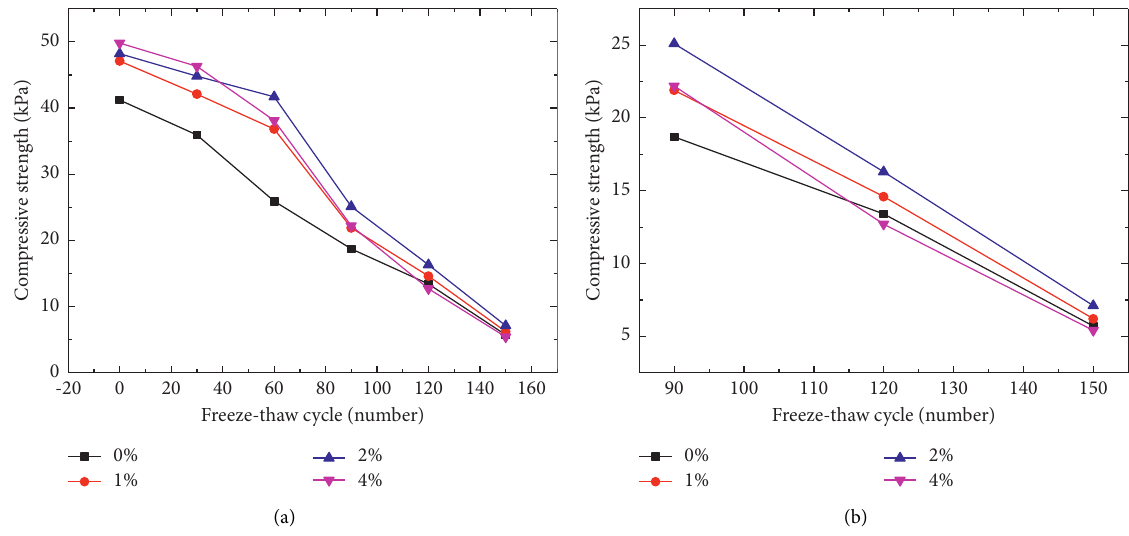
Figure 7: The compressive strength of specimens after (a) 0–150 freeze-thaw cycles and (b) 90–150 freeze-thaw